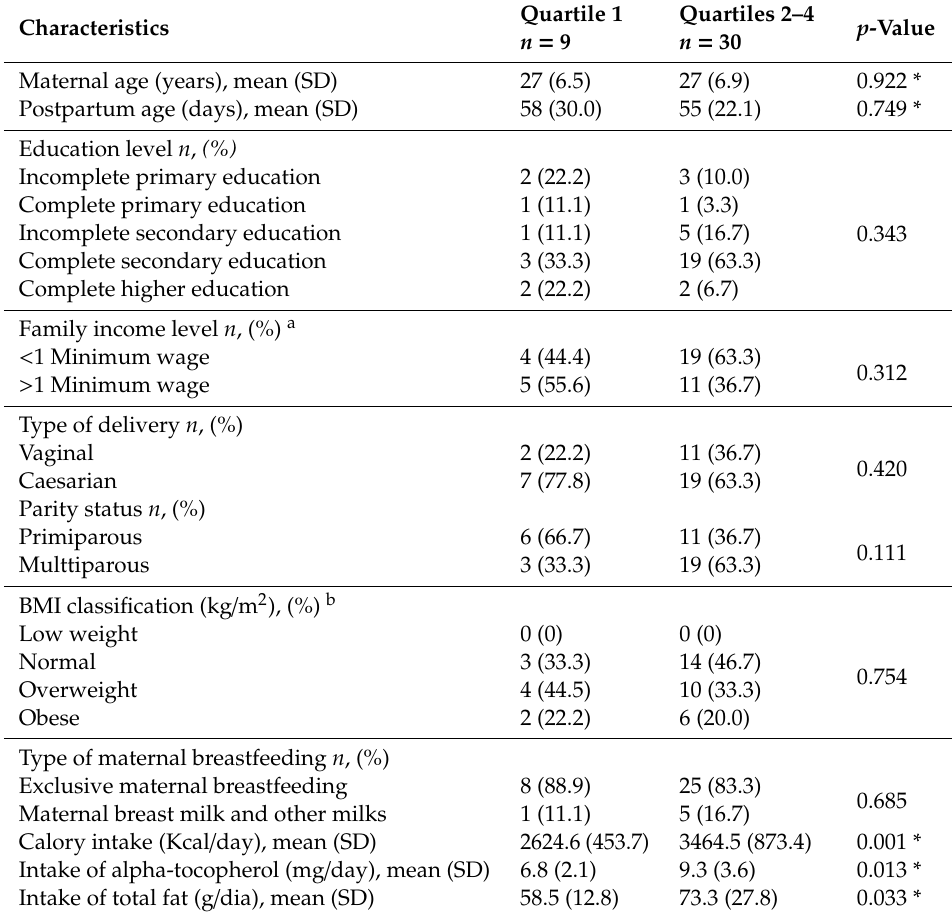
Table 4. Characterization of the 39 lactating women randomized into the supplemented group, divided by the e ff ect of milk supplementation (lower e ff ect: quartile 1, equivalent to 83% of the vitamin increase percentage in the milk, and greater e ff ect: quartiles 2–4). Natal, Rio Grande do Norte, Brazil,